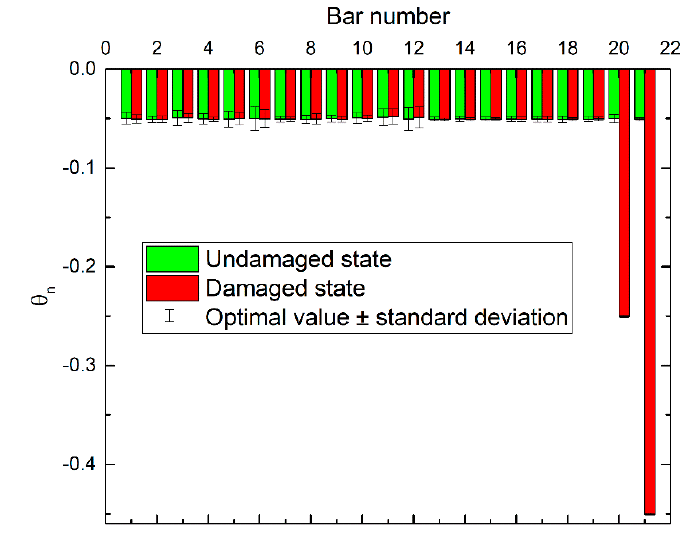
Figure 8. Updated perturbation scaling factors of stiffness for truss model.